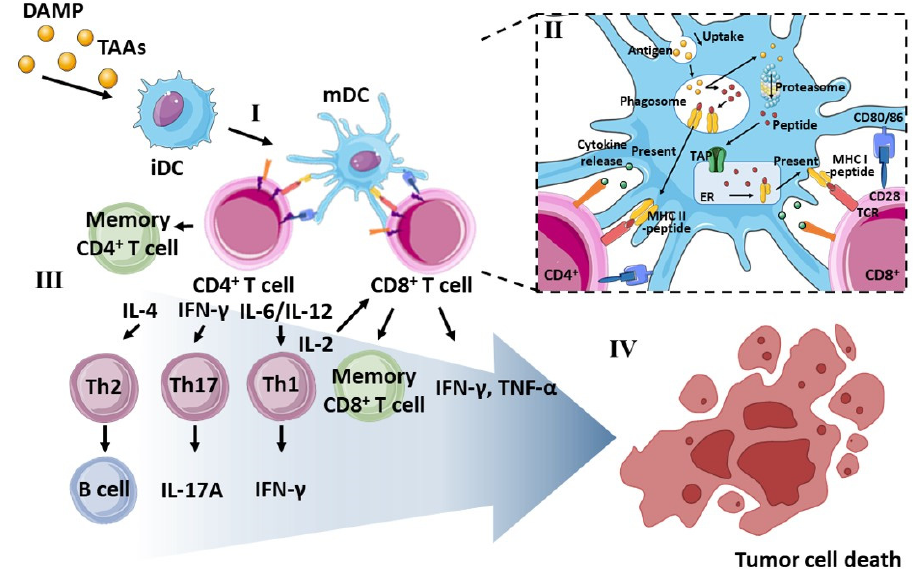
Figure 1. Overview of DC and T cell interplay for anticancer immunotherapy. ( I ) Differentiation of stimulated immature DCs (iDCs) by DAMP molecules and TAAs to mature DCs (mDCs), ( Ⅱ ) process of antigen presentation via MHC molecules in DCs, ( Ⅲ ) priming of T cells to effector T cells, ( Ⅳ ) induction of the tumor cell death by various types of T cells. Reproduced with permission from [10] ; images used are from Servier Medical Art.